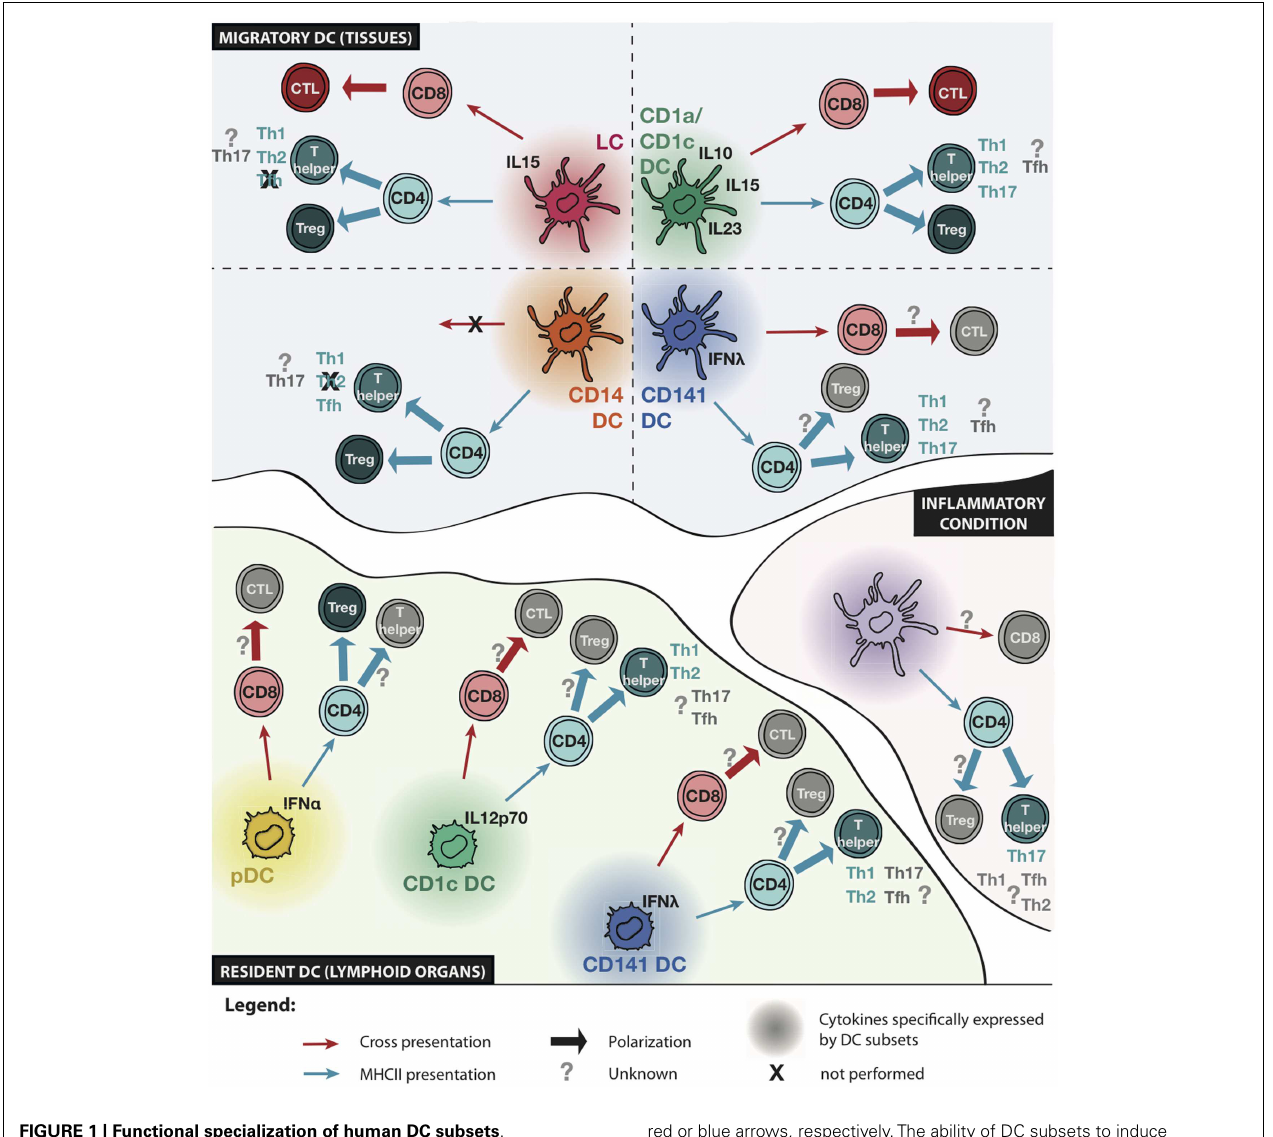
FIGURE 1 | Functional specialization of human DC subsets . Schematic representation of known and unknown functional specialization of migratory and resident DC subsets, and inflammatory DCs. Cytokines specifically expressed by a given DC subset are indicated. The ability to present antigens to CD8 or CD4T cells is represented with